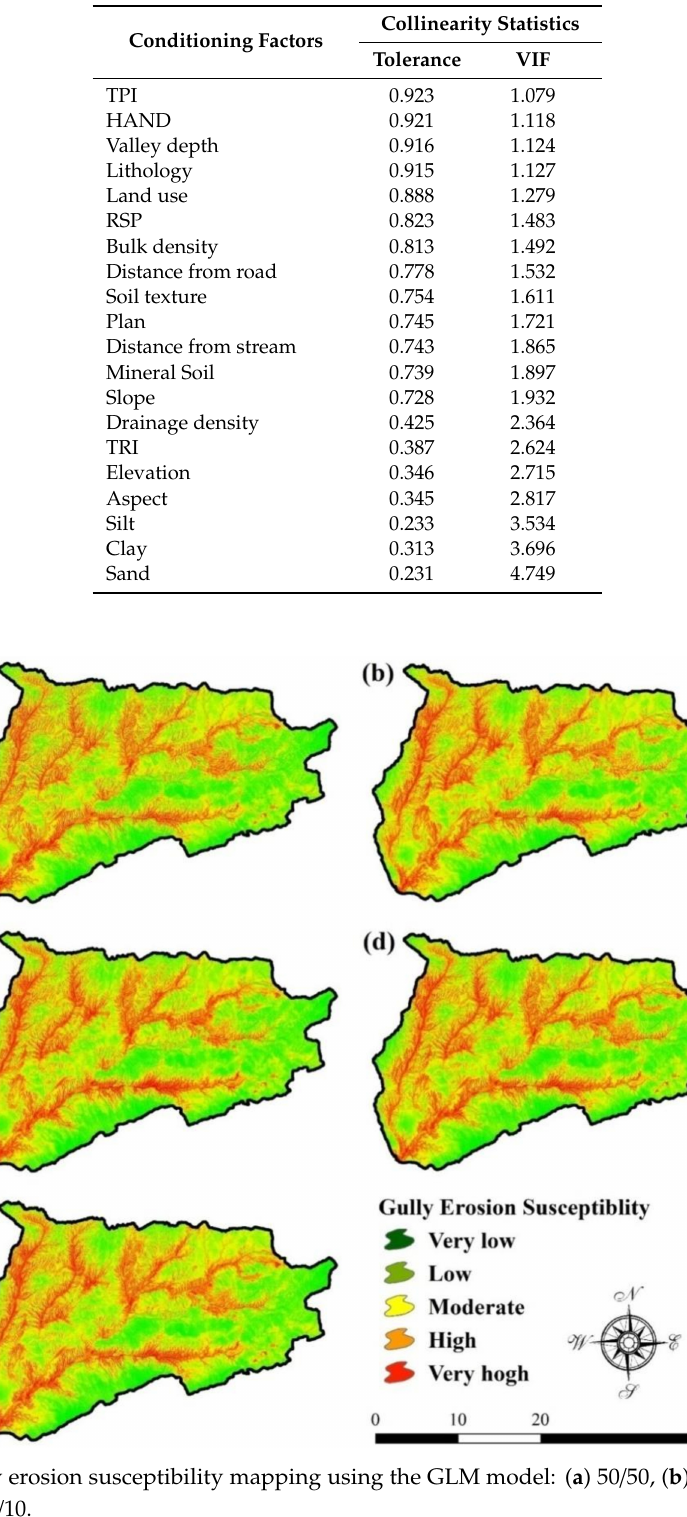
Table 4. Multi-collinearity analysis of the gully conditioning factors.